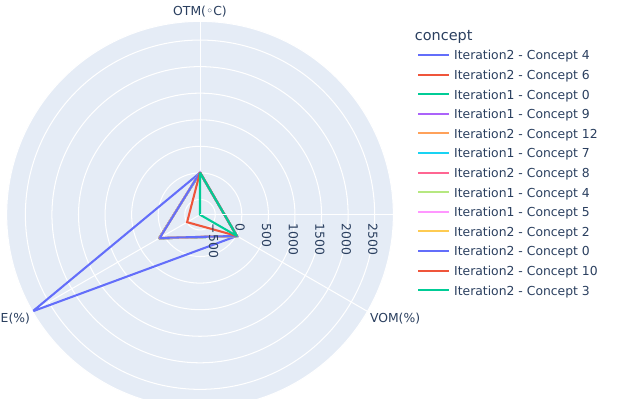
Figure 7. Comparing concepts of both the iterations (after receiving chunk 2 and 3, Iteration 1 and 2, respectively) using the relationship between OTM, VOM, and SE, when OTM < 10 ◦ C. Note that some of the concepts in the legend are not visible in the image due to overlap.